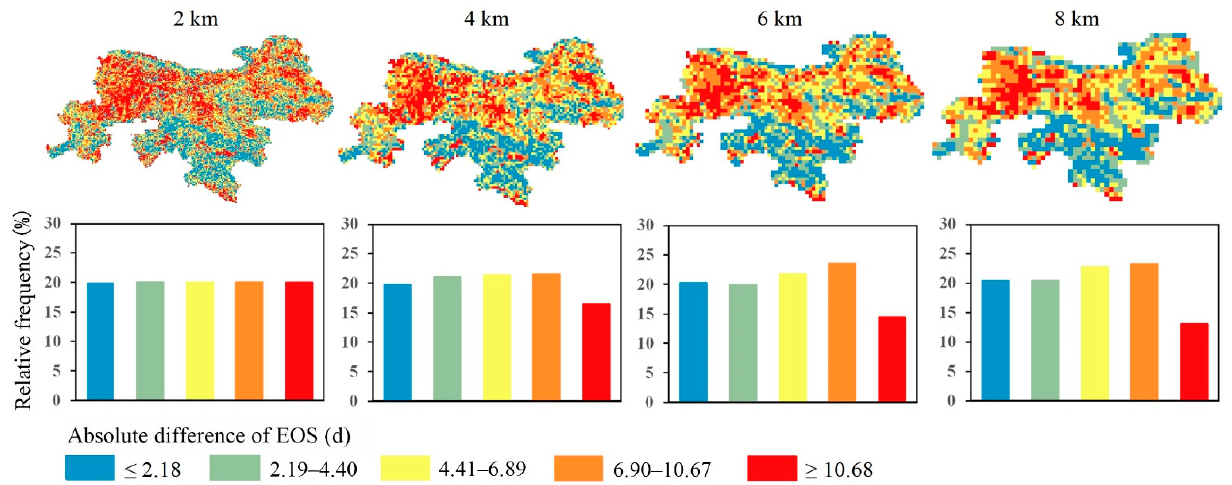
Figure 15. Absolute differences between the up-scaled results from the 250 m EOS obtained by SG-filtering and the 1000 m EOS obtained by AG-filtering at different scales. Days 2.18, 4.40, 6.89, and 10.67 correspond to the 20%, 40%, 60%, and 80% cumulative frequency of the 2 km EOS difference, respectively.